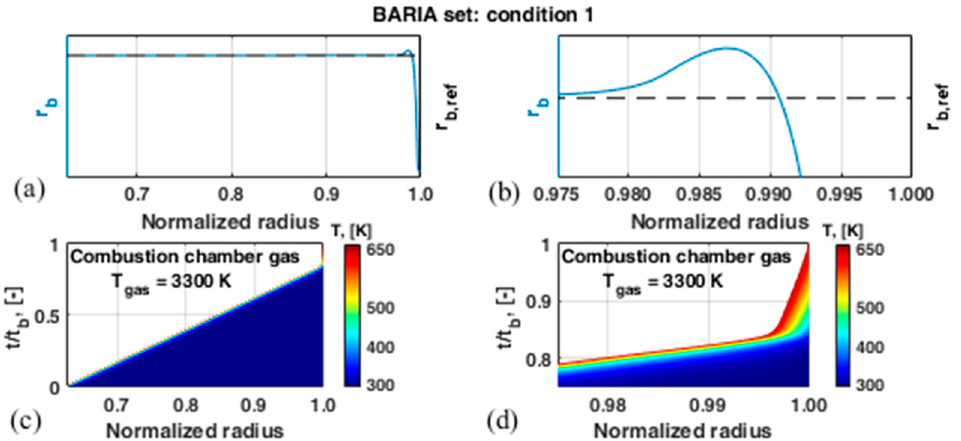
Figure 15. Example of the heat equation model solution with reference to the BARIA set of condition 1: ( a ) burn rate vs normalized radius for condition 1; ( b ) zoom of the burn rate in the tail-off region; ( c ) grain temperature map varying with nondimensional time and nondimensional radius; ( d ) zoom of the grain temperature map in the tail-off region.